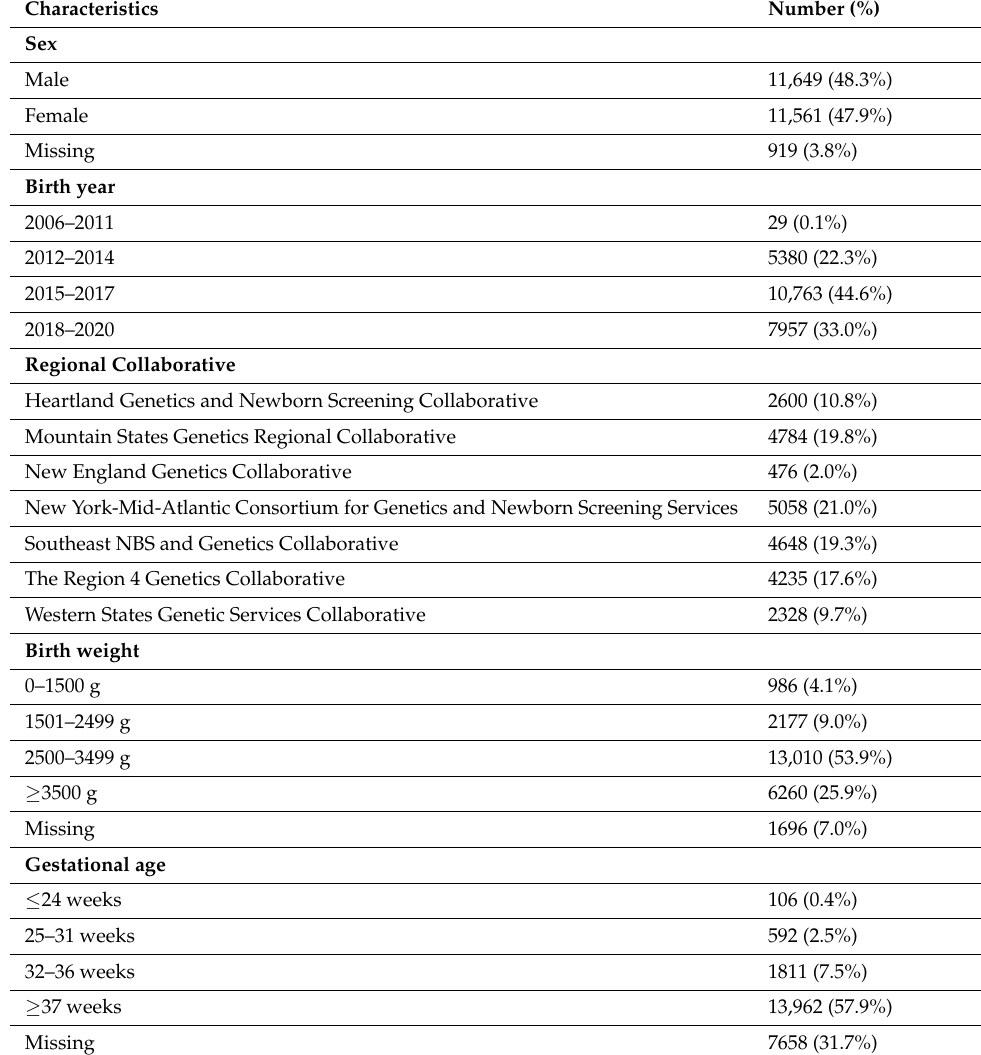
Table 1. Characteristics of infants in 45 states with newborn screening disorders in NewSTEPs data as of 31 August 2020 ( n = 24,129